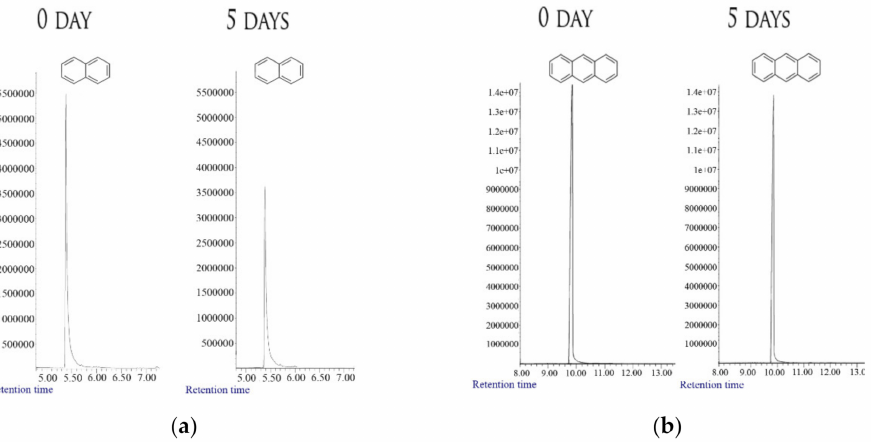
Figure 1. Gas chromatographic analysis of the reduction in the concentration during Aspergillus glaucus AL1 culturing: ( a ) naphthalene—in the beginning (0.3 g/L) and after 5 days (0.2 g/L); ( b ) anthracene—in the beginning (0.32 g/L) and after 5 days (0.24 g/L). Naphthalene degraded faster than anthracene. For 5 days, naphthalene’s